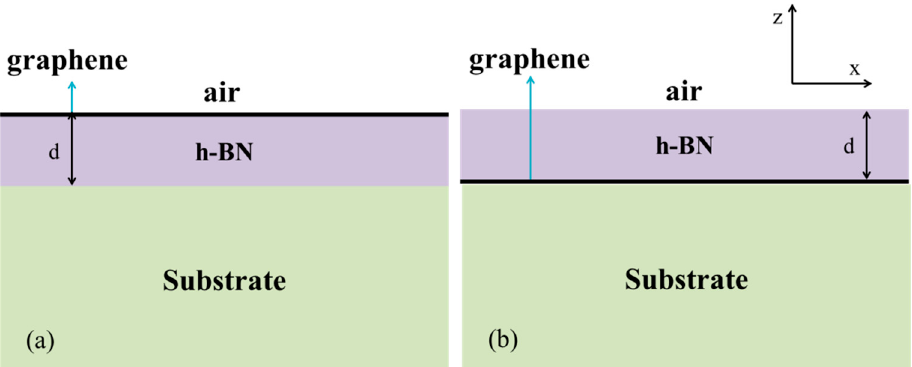
Figure 4. Schematic of the coupling mode in our calculation, ( a ) SPPs excited first ( b ) HPPs excited first. Monolayer graphene is located on h-BN (a) and in the center of the h-BN and substrate (b). We assume that these 2D structures are infinite in the xy-plane. Here, the substrate we use is SiO 2 .